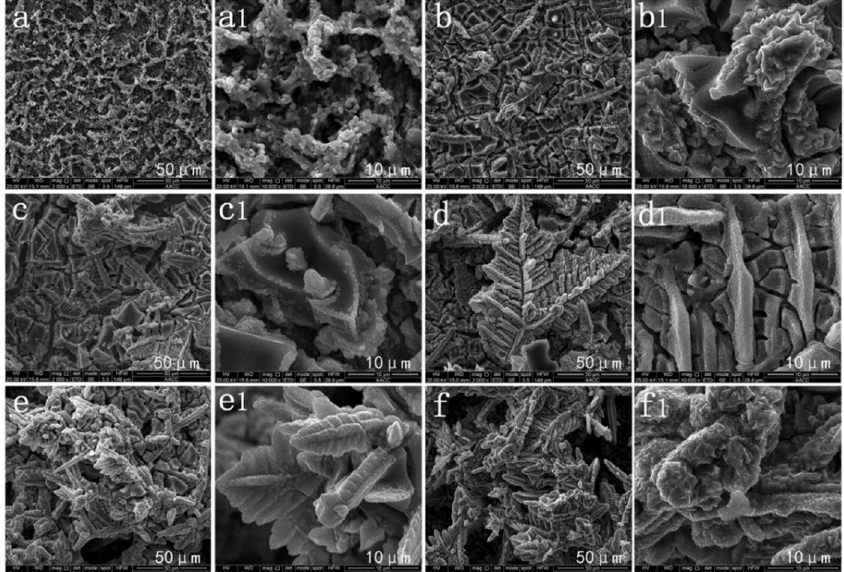
Figure 14. The morphological variation of the deposited Cu coating with different immersion times: ( a ) 0 min; ( b ) 3 min; ( c ) 6 min; ( d ) 9 min; ( e ) 12 min; ( f ) 15 min; ( a1 – f1 ) are images magnified 5 times by ( a – f ). Reprinted with permission from Ref [68]. Copyright 2016 Elsevier.